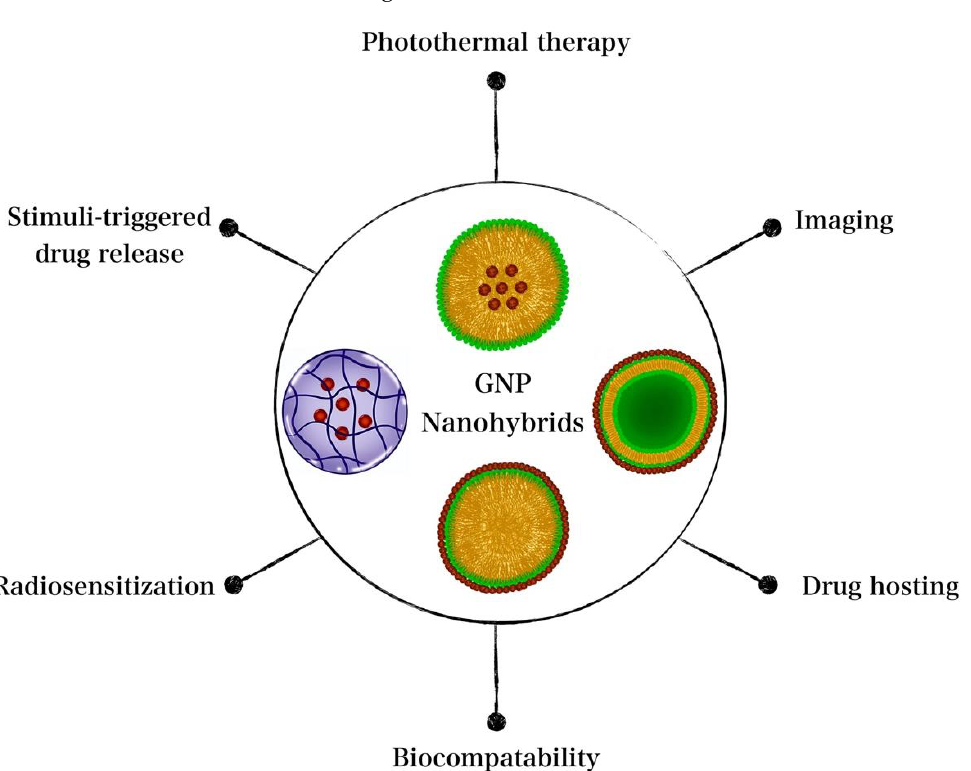
Figure 4. Advantages provided by GNP nanohybrids for cancer theragnostics.